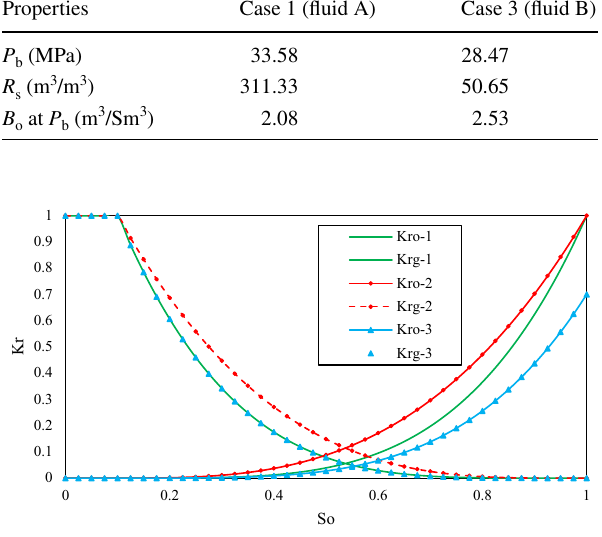
Fig. 12 Relative permeability